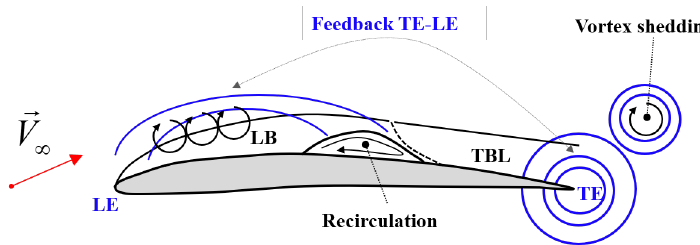
Figure 1. Representation of the main noise sources around an